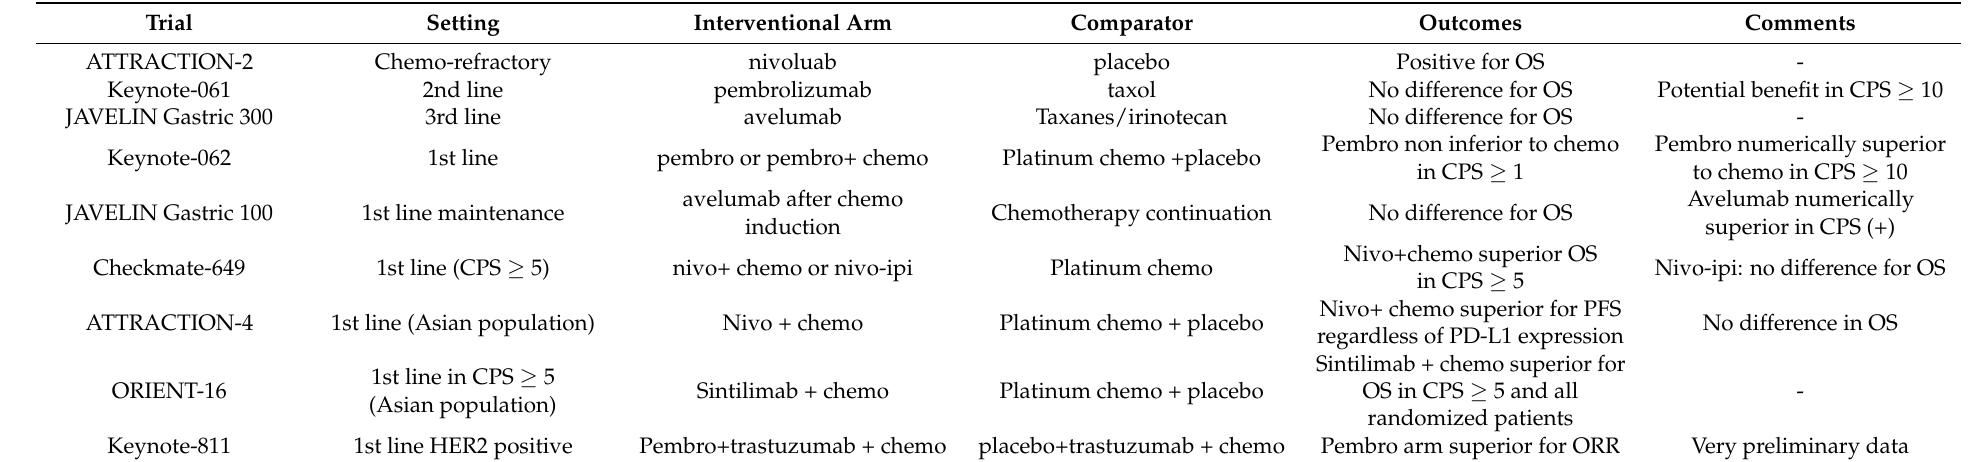
Table 1. Summary of phase 3 trials of immunotherapy in gastric